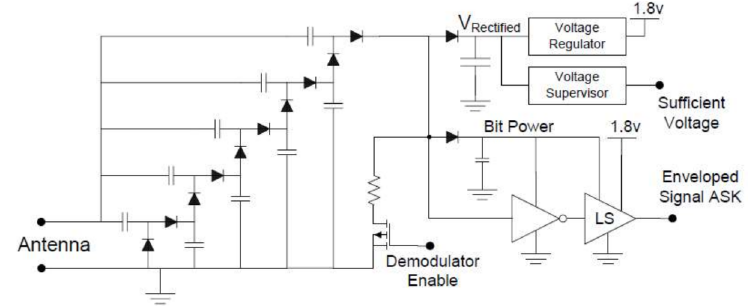
Figure 3. Schematic of harvesting ( left ) and ASK demodulation ( right )